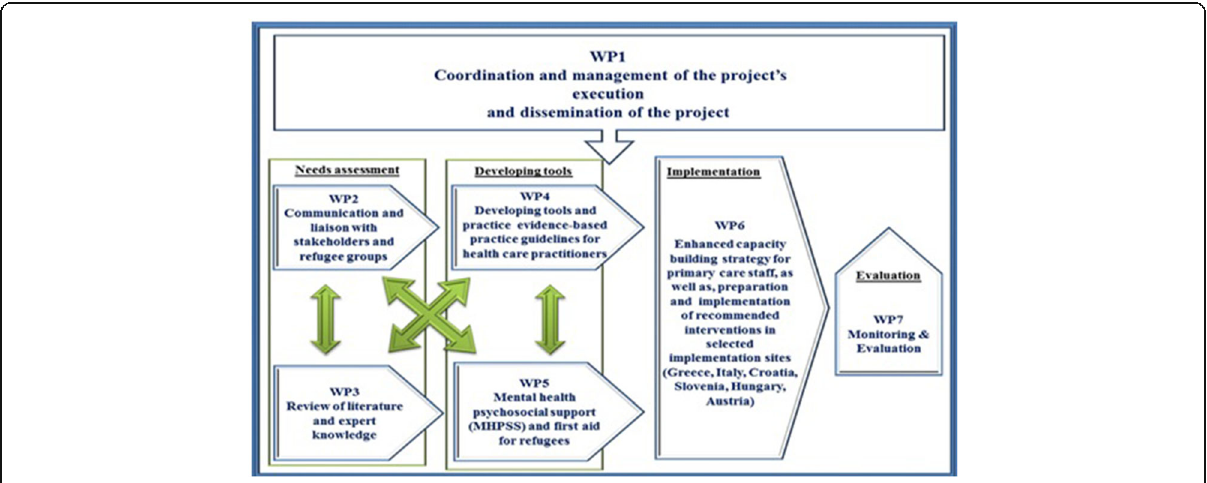
Fig. 1 EUR-HUMAN work plan (Source: